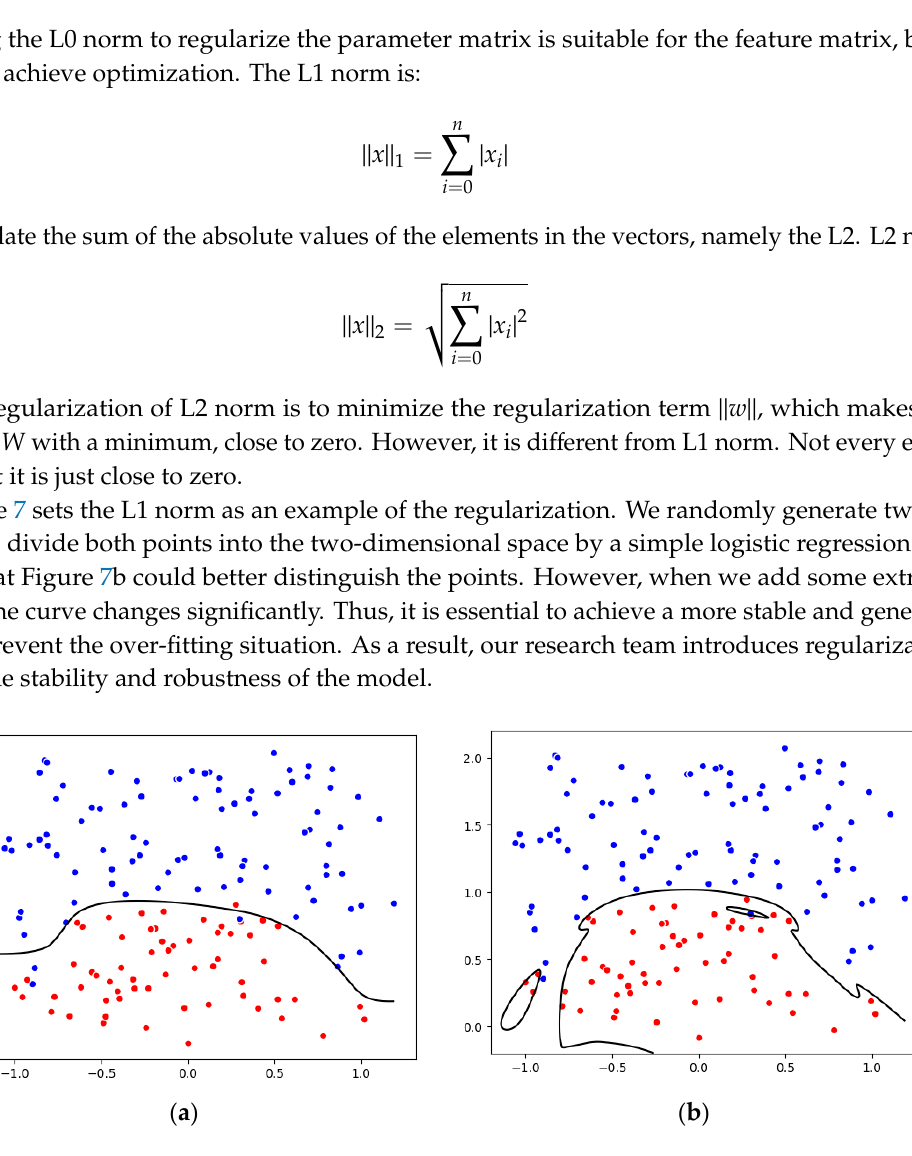
Table 4. Basic Data in the Dataset. Batch ID